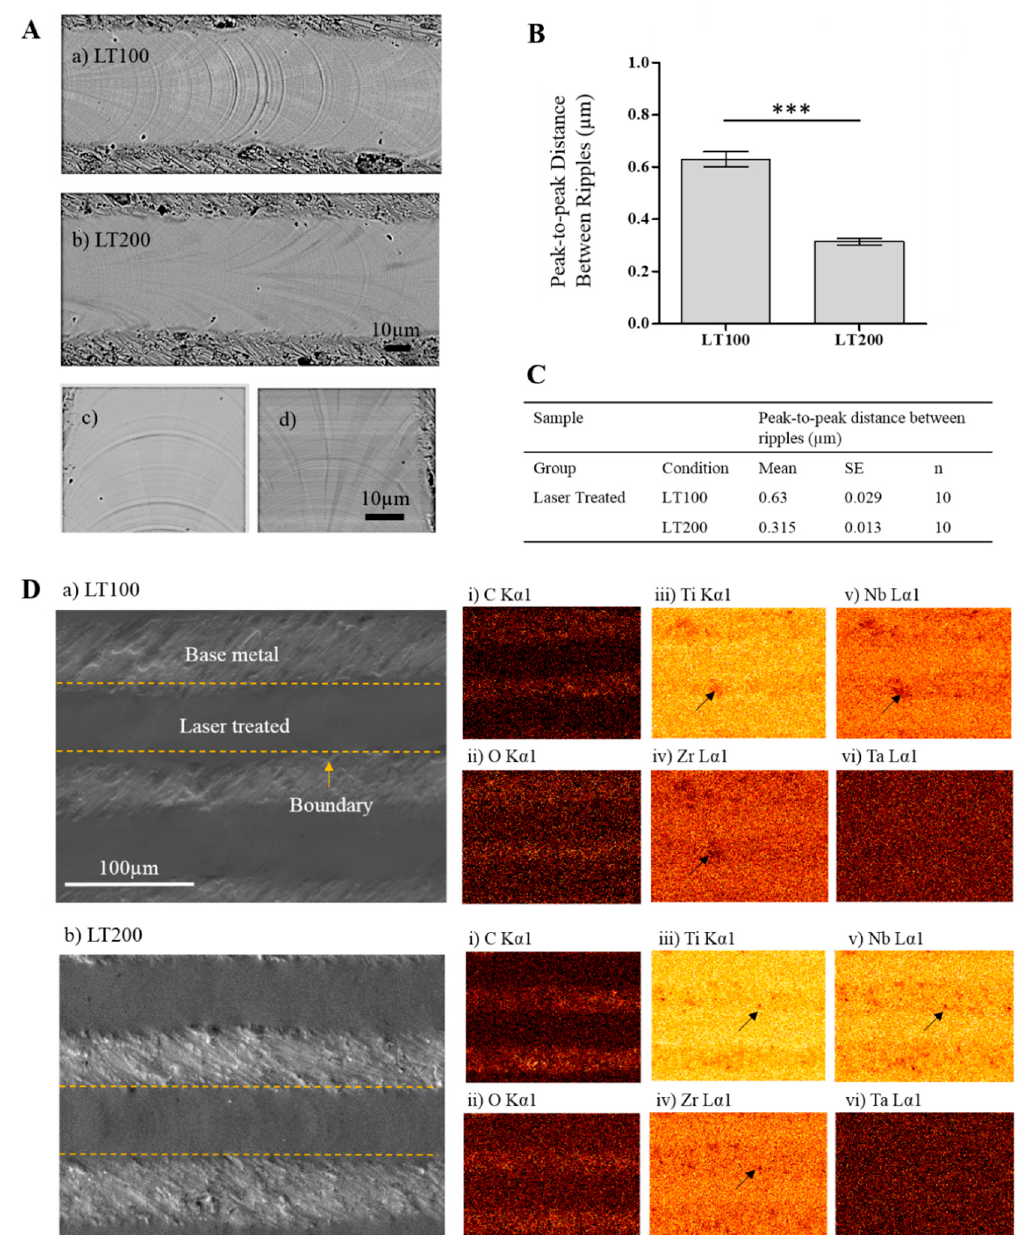
Figure 2. Distinctive microscale ripples and homogenous elemental distribution achieved through laser surface treatment. (A) SEM images of the multi-scale ripples created within the laser tracks. Scale bar = 10 µm. (B) Peak-to-peak distance between ripples, calculated using ImageJ. Error bars are the SE of n = 10. (C) Tabulated peak-to-peak distance between ripples. (D) SEM-EDX images showing the laser treated surfaces, with a boundary defining the base metal polished and laser treated areas. Scale bar = 100 µm. EDX elemental maps show the spatial distribution of carbon, oxygen, titanium, niobium, zirconium and tantalum. Black arrows indicate particle enrichment in the base metal polished zones for all elements except tantalum.